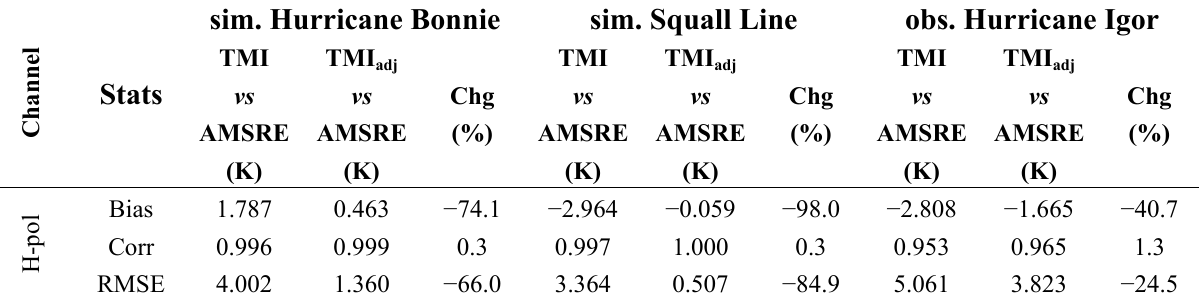
Table 2. Statistics of comparison between TMI 85 and AMSR-E 89 GHz-H before and after calibration for hurricane Bonnie and Squall line simulations and the observed hurricane Igor.